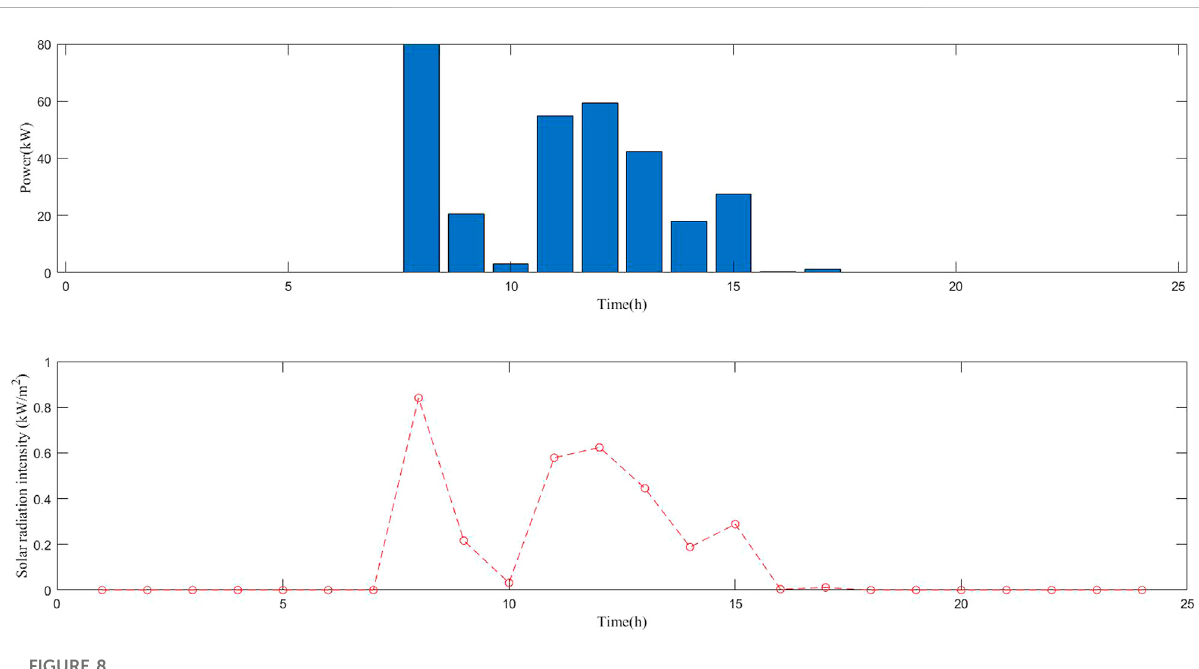
FIGURE 8 Building virtual energy storage and temperature